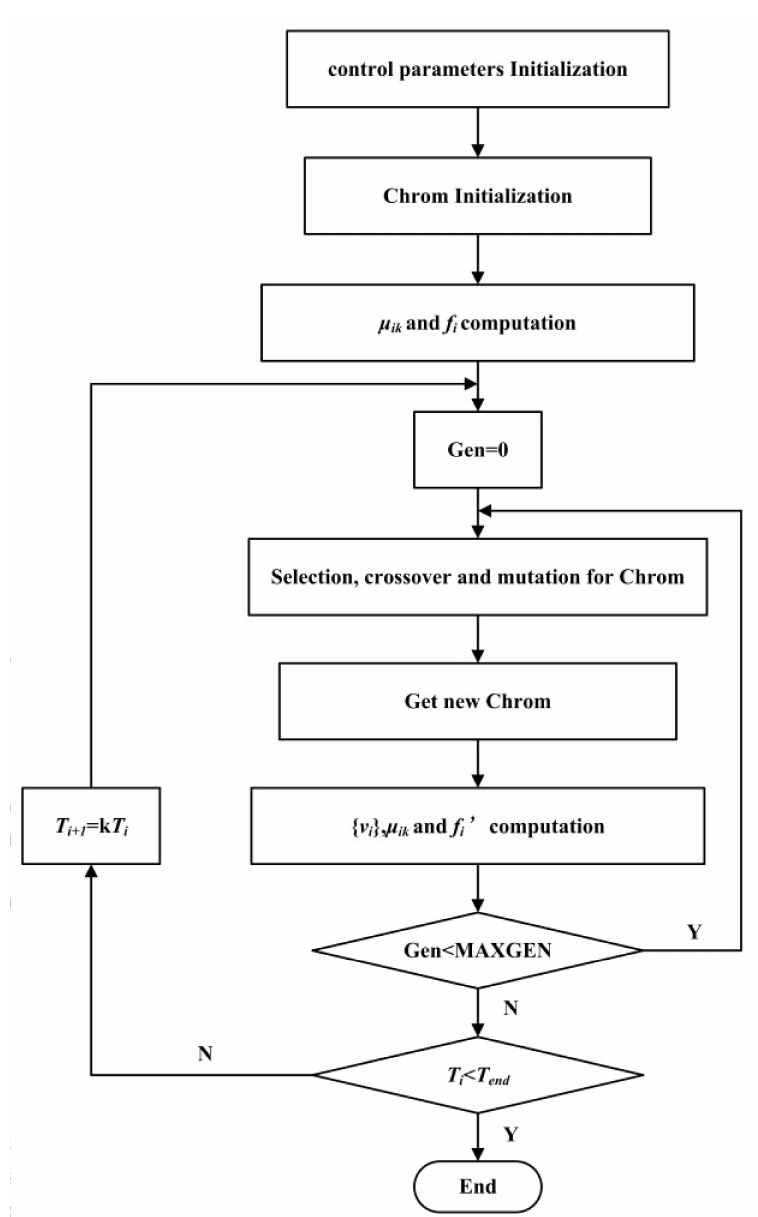
Figure 1. Flowchart of the SAGA-FCM